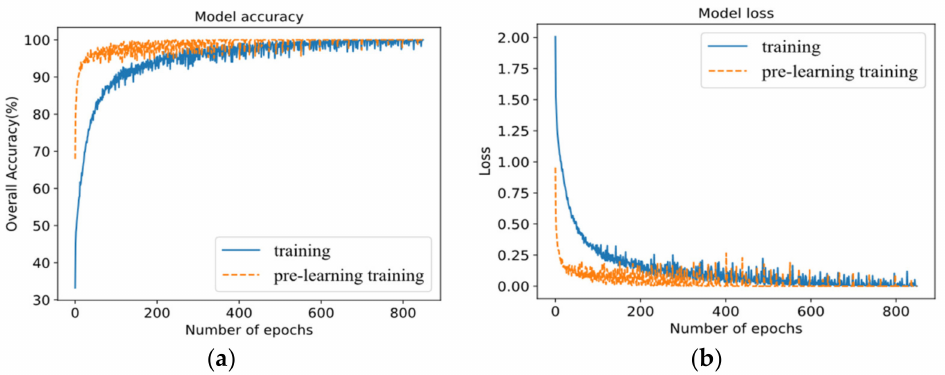
Figure 6. Comparison of different training strategies: ( a ) Accuracy convergence speed and ( b ) Loss convergence speed of Two-CNN fre-spe